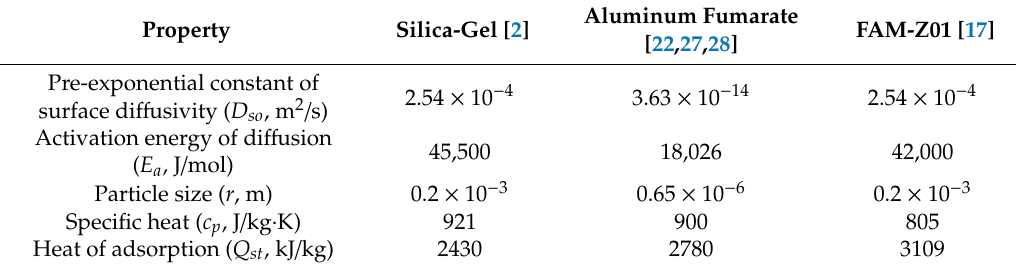
Table 2. Physical properties of